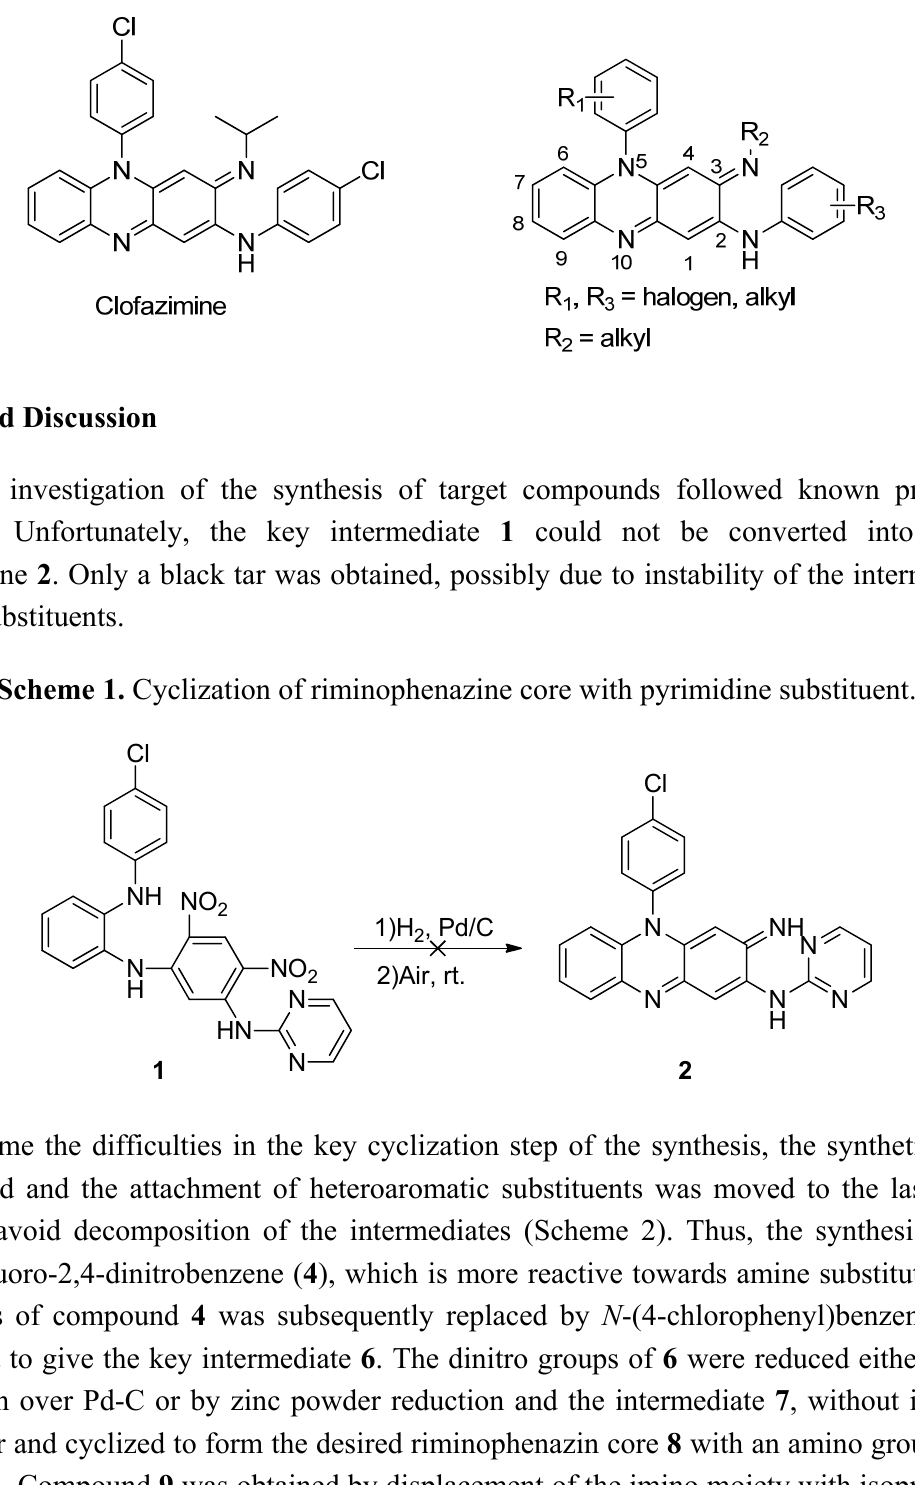
Figure 1. Chemical structures of clofazimine and known riminophenazine